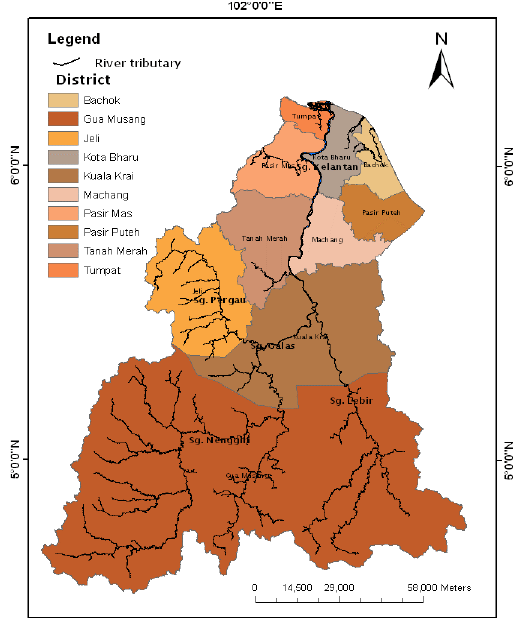
Figure 1. Sungai Kelantan tributaries and Kelantan district